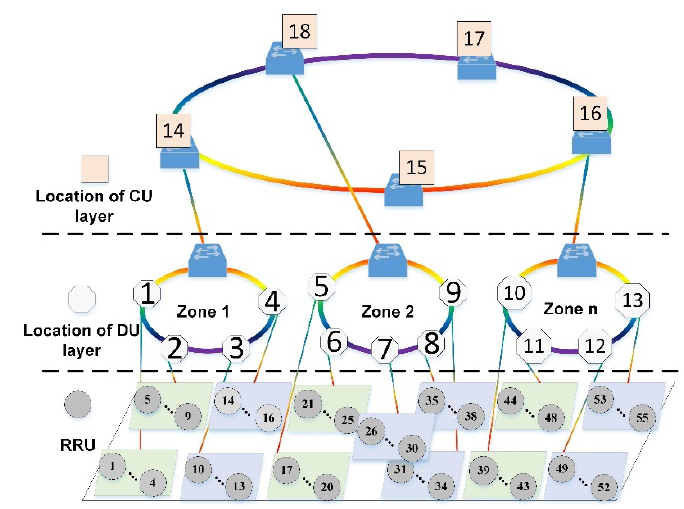
Figure 4. Simulation network topology.